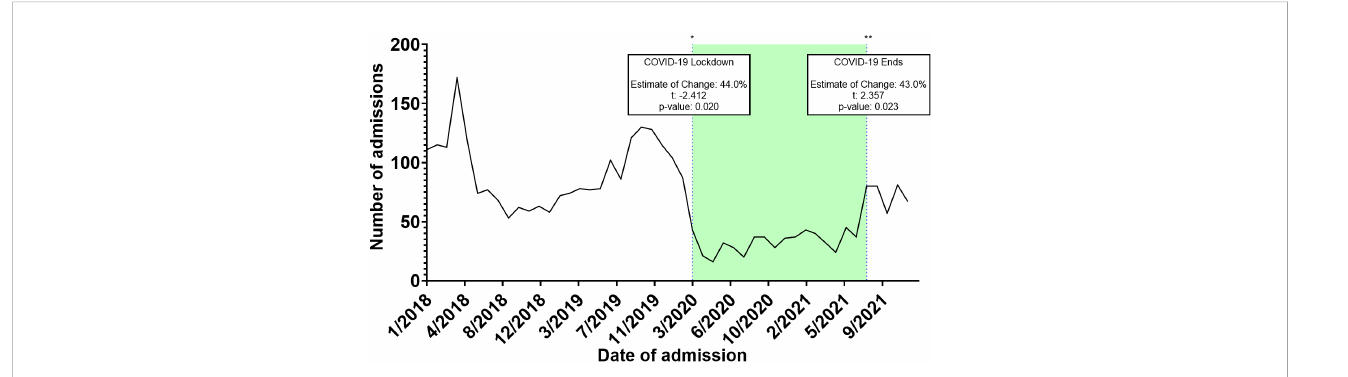
FIGURE 1 Interrupted time series (ITS) analysis of different COVID-19 related events on the admissions trends of patients from areas of con fl